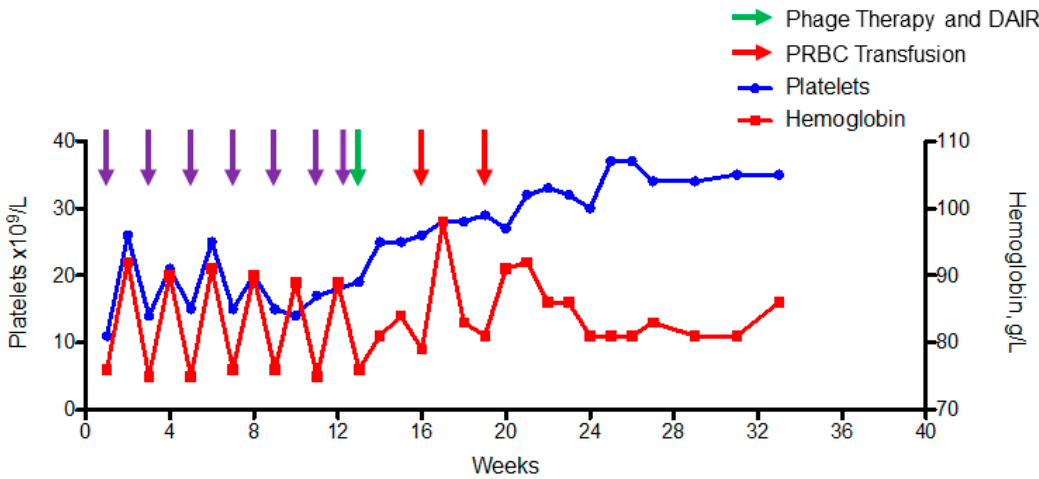
Figure 1. Graph of baseline hemoglobin and platelet levels showing the need for biweekly transfusions of both platelets and packed red blood cells (purple arrows) before DAIR and adjuvant bacteriophage therapy (green arrow). After bacteriophage therapy, the patient had transfusion of packed red blood cell transfusion at week 16 and 19 but no other transfusions have been required since DAIR and adjuvant bacteriophage therapy supporting bone marrow partial recovery and stabilization of